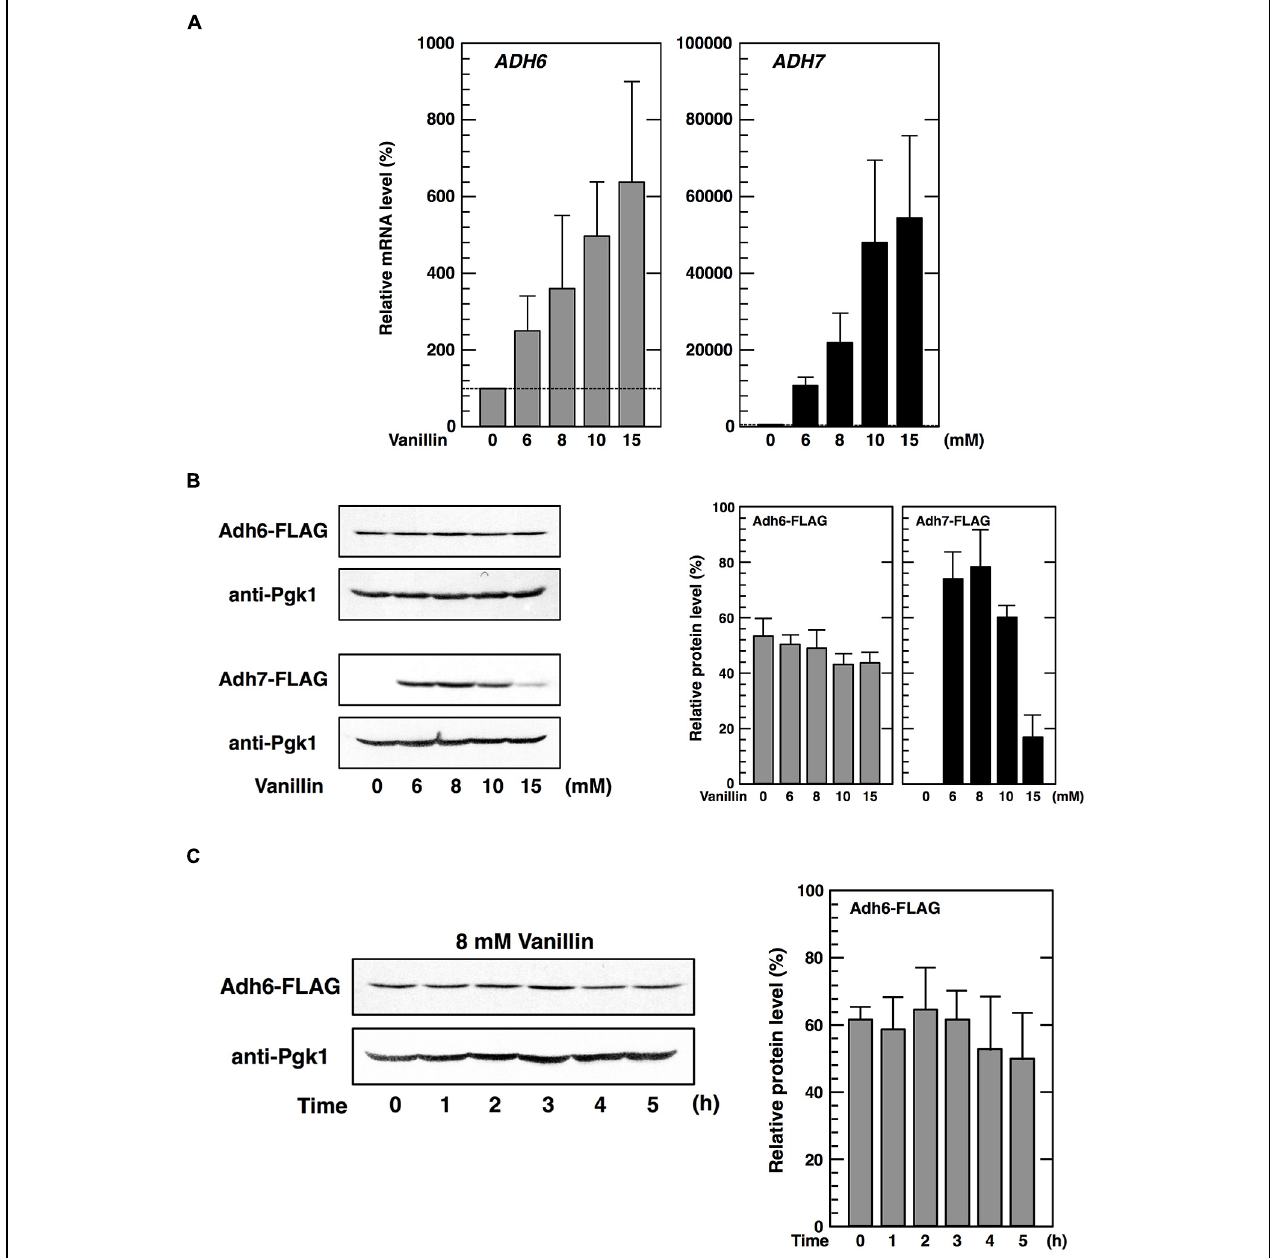
FIGURE 2 | Expression of the ADH6 and ADH7 genes under vanillin stress. (A) The mRNA levels of ADH6 and ADH7 were analyzed by qRT-PCR. Cells in an exponential phase of growth were treated with vanillin (6–15 mM) for 60 min. To compare mRNA expression levels, the mRNA level of each gene was normalized to that of ACT1 . The mRNA level in cells without vanillin treatment was considered 100%. Data are shown as mean ± SD of three independent experiments. (B,C) Levels of Adh6 and Adh7 protein expression were determined by western blot analysis using an anti-FLAG antibody. Cells carrying a FLAG-tagged chromosomal copy of ADH6 or ADH7 gene were treated with the indicated concentrations of vanillin for 60 min (B) , or treated with 8 mM vanillin for the indicated periods of time (C) . Pgk1 was used as a loading control. Protein levels of Adh6 and Adh7 were normalized to that of Pgk1 using ImageJ, and the intensity of Pgk1 band of each lane was considered 100%. Data are shown as the mean ± SD of three independent